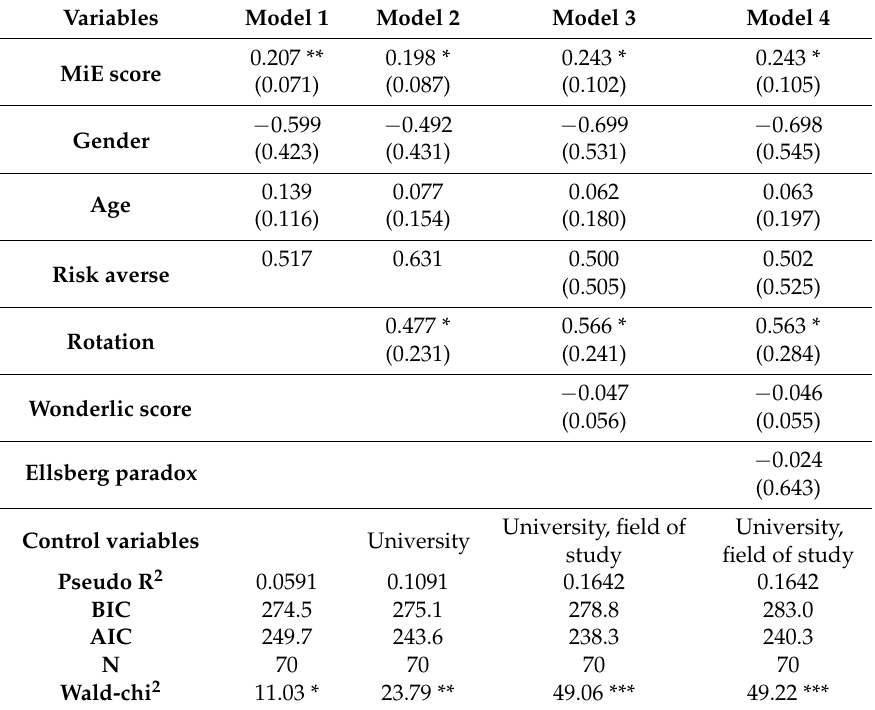
Table 3. Dictator game regression models (Ordered Logit